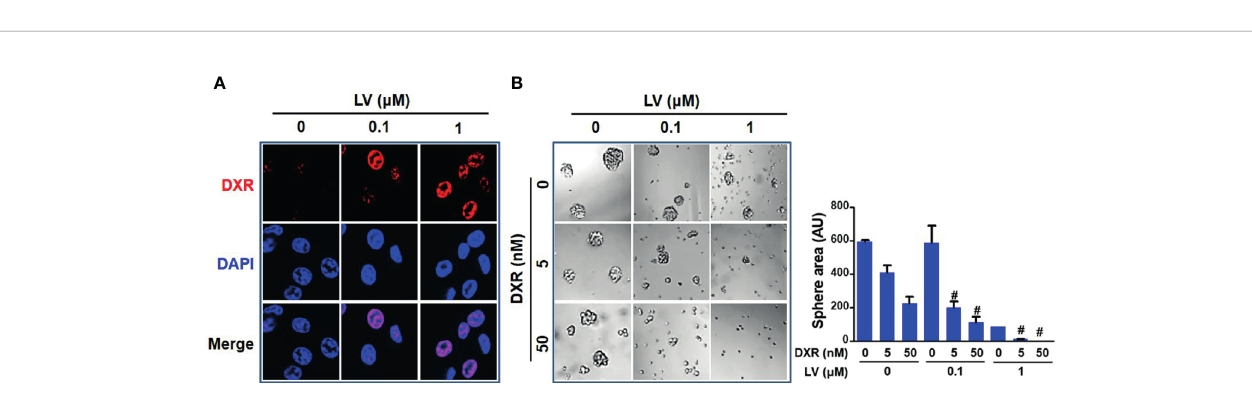
FIGURE 4 | Lovastatin increases the sensitivity of TNBC CSCs to doxorubicin. Intracellular accumulation of DXR promoted by lovastatin. MDA-MB-231 CSCs were treated for 24 h with DXR (5 m M), alone or in combination with lovastatin, and the intracellular fl uorescence of DXR (red) was observed by laser scanning confocal microscopy. Original magni fi cation: 63× (A) . Synergistic effect between lovastatin and DXR on inhibiting tumorsphere-forming activity. MDA-MB-231 CSCs were cultured in the presence or absence of lovastatin and/or DXR and the tumorspheres were observed and recorded 5 d after treatment. Right, quanti fi cations of the areas of tumorspheres (B) . # CI < 1.0, showing synergism between the two drugs. LV, lovastatin; DXR, doxorubicin; AU, arbitrary